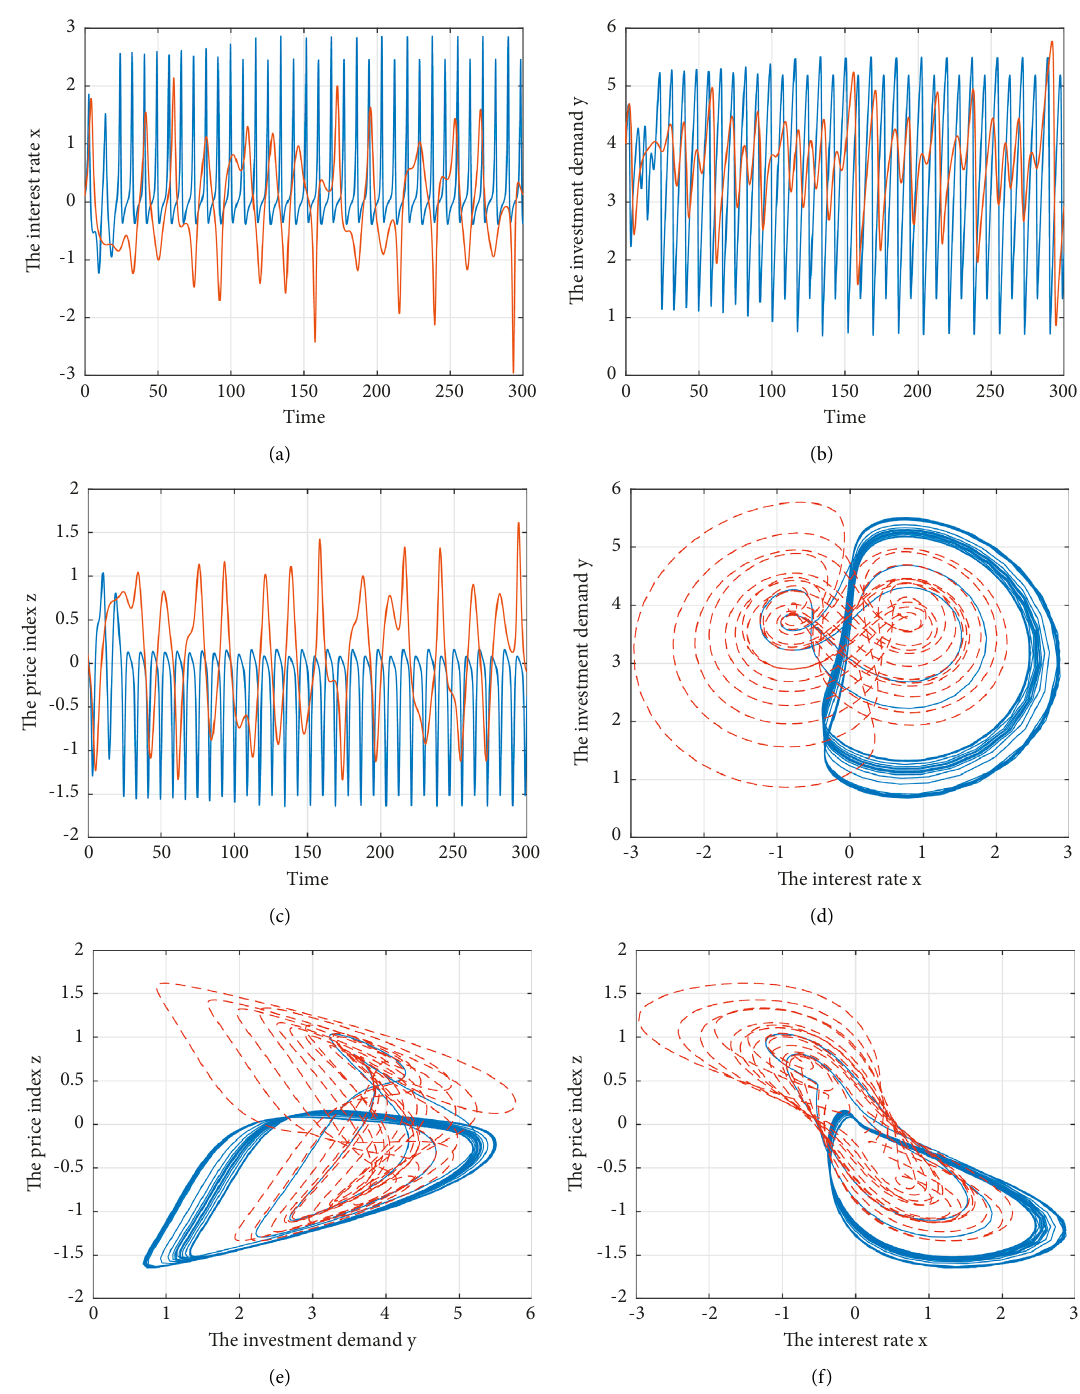
Figure 3: Illustration of time series analysis and chaotic behaviour of the proposed fractional model (2) of the financial system with the input parameters a � 3 . 0 ,b � 0 . 1 , c � 1 . 0, and ϑ � 0 .